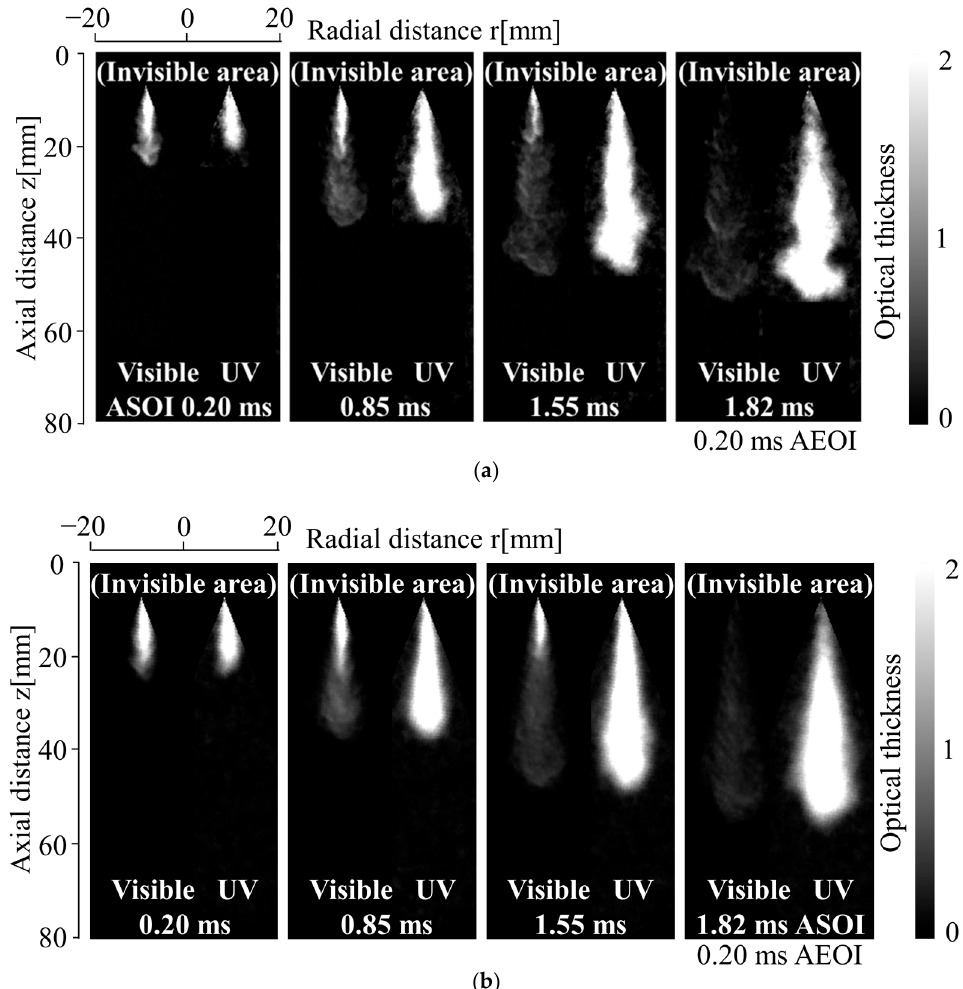
Figure 5. Spray images in optical thickness at Vis and UV wavelengths (T a = 800 K, P a = 4.8 MPa, P inj = 100 MPa, M f = 5.0 mg). ( a ) Single Shot. ( b ) Average Shot. P inj = 100 MPa, M f = 5.0 mg). ( a ) Single Shot. ( b ) Average